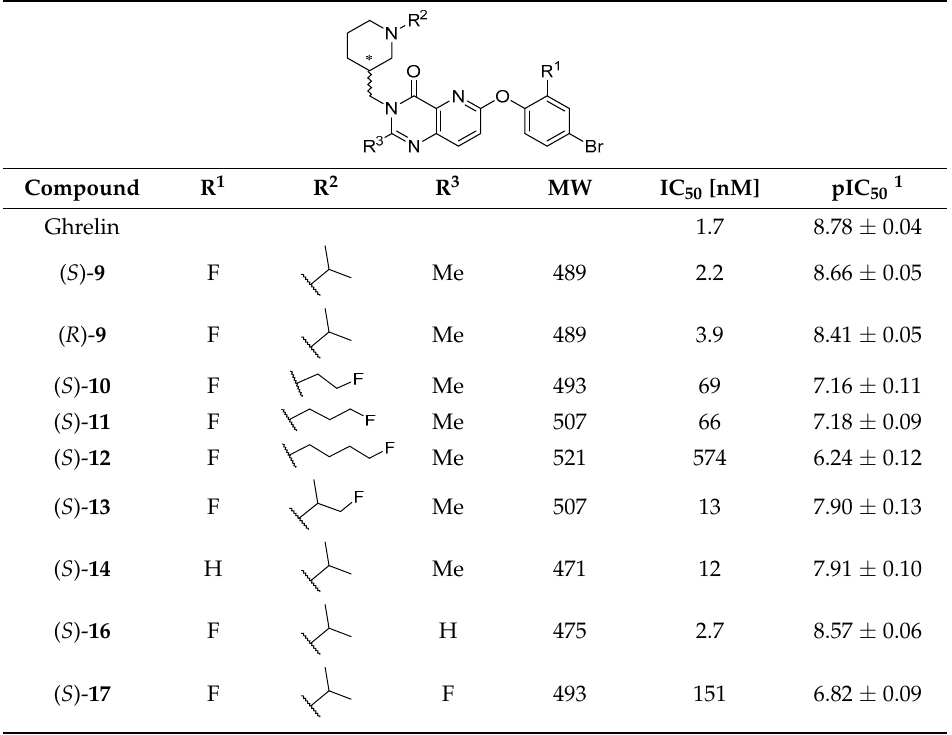
Table 1. Competitive binding assay at HK293 cell membranes expressing hGhrR (human ghrelin receptor) with [ 125 I-His 9 ]ghrelin.